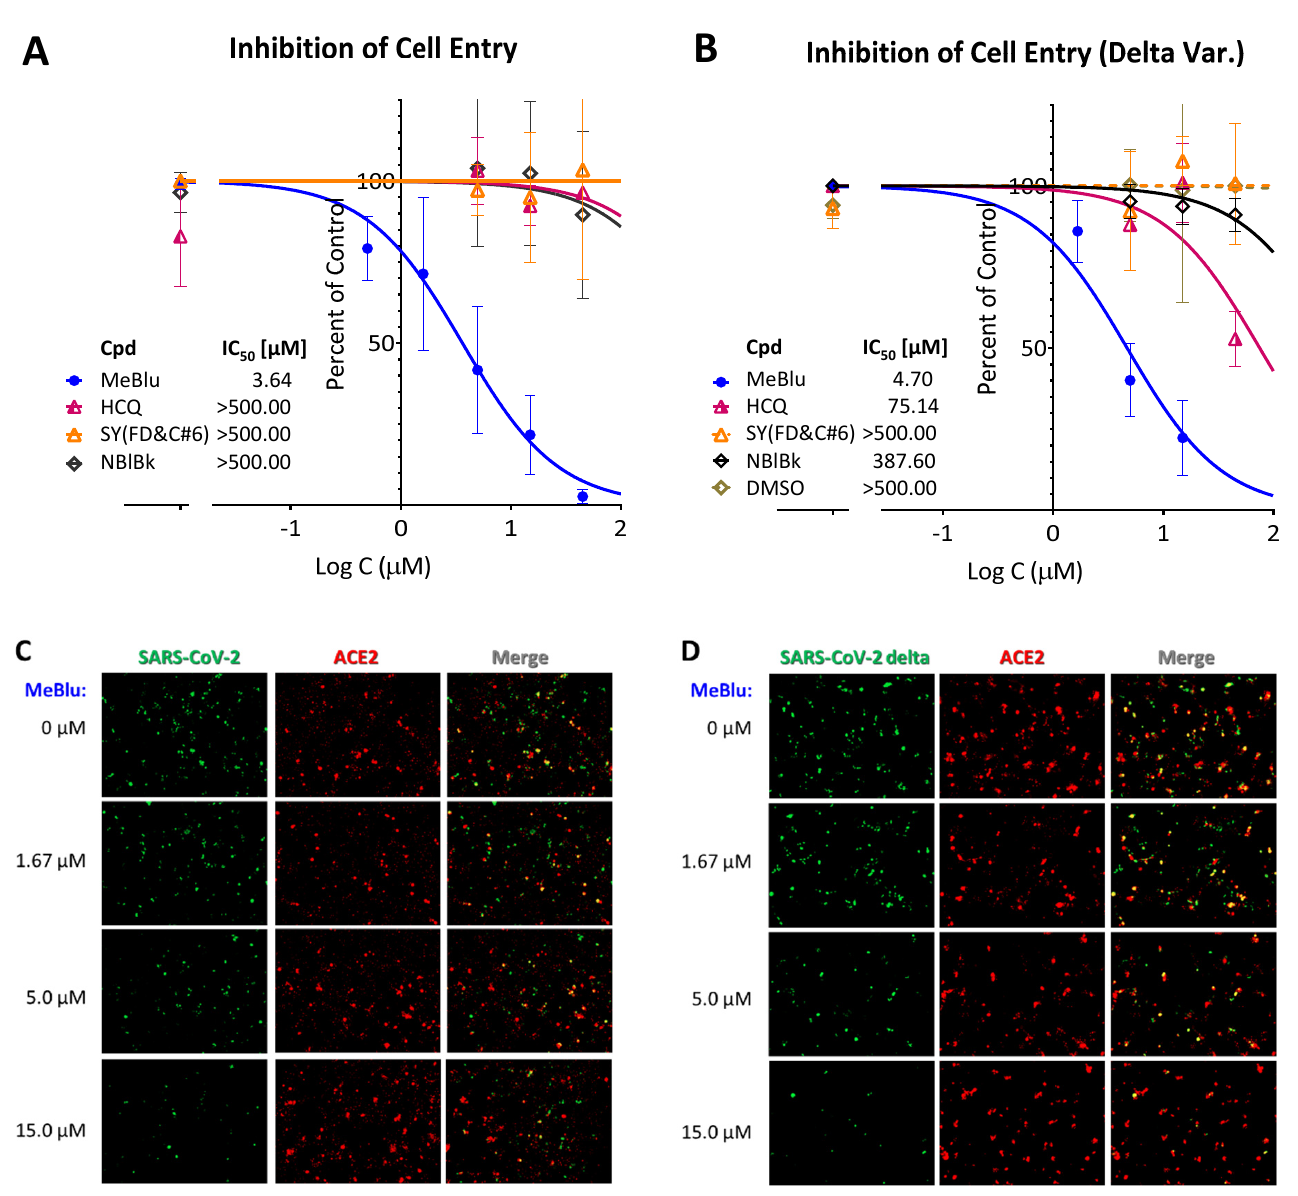
Figure 4. Concentration-dependent inhibition of the entry of SARS-CoV-2 pseudoviruses (BacMam) into ACE2-expressing cells by MeBlu. Quantification of entry of pseudoviruses bearing the original ( A ) or the delta (B.1.617.2) variant ( B ) of the SARS-CoV-2 S protein (plus green fluorescent protein reporters; BacMam based) in ACE2 (plus red fluorescence)-expressing host cells (HEK293T). Values were obtained as before from the quantification of the amount of green present [12,23], as green fluorescence is expressed only in pseudovirus infected cells. Data are shown as percent of control on semilogarithmic scale and fitted with classic sigmoidal curve used to calculate IC 50 s for MeBlu as well as the control compounds included (hydroxychloroquine, HCQ, sunset yellow, SY, and naphthol blue black, NBlBk). A set of corresponding representative images from serial dilution experiments with MeBlu and the BacMam-based pseudovirus bearing the SARS-CoV-2 S proteins are shown in ( C , D ) for illustration.